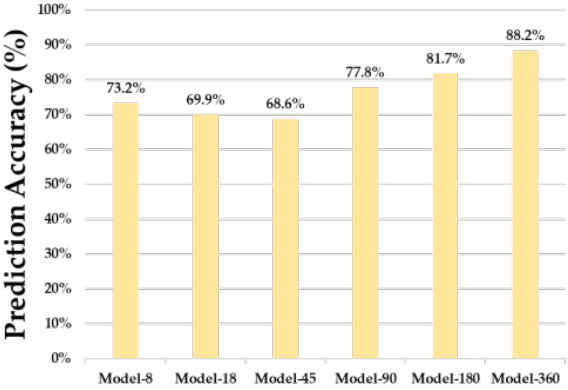
Figure 15. Prediction Accuracy while Driving.